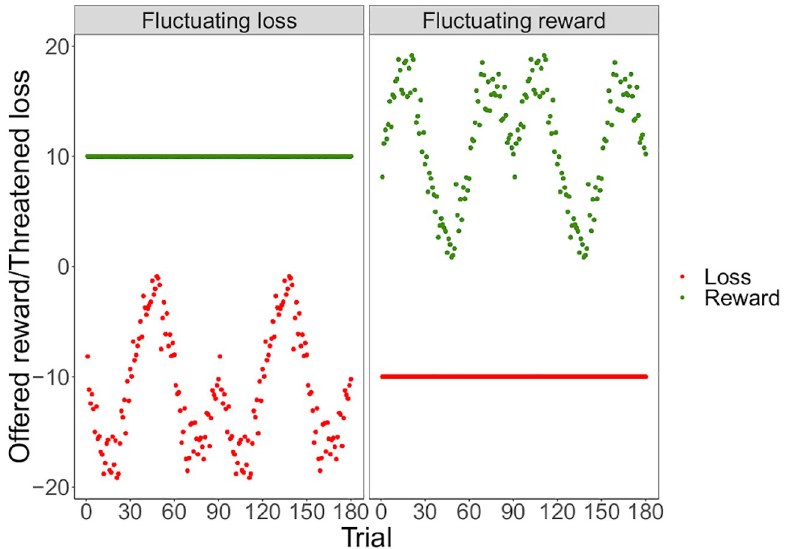
Fig 5. Offered rewards and threatened losses. Offered monetary reward and threatened monetary loss on each trial of the judgement bias task in the fluctuating reward and loss